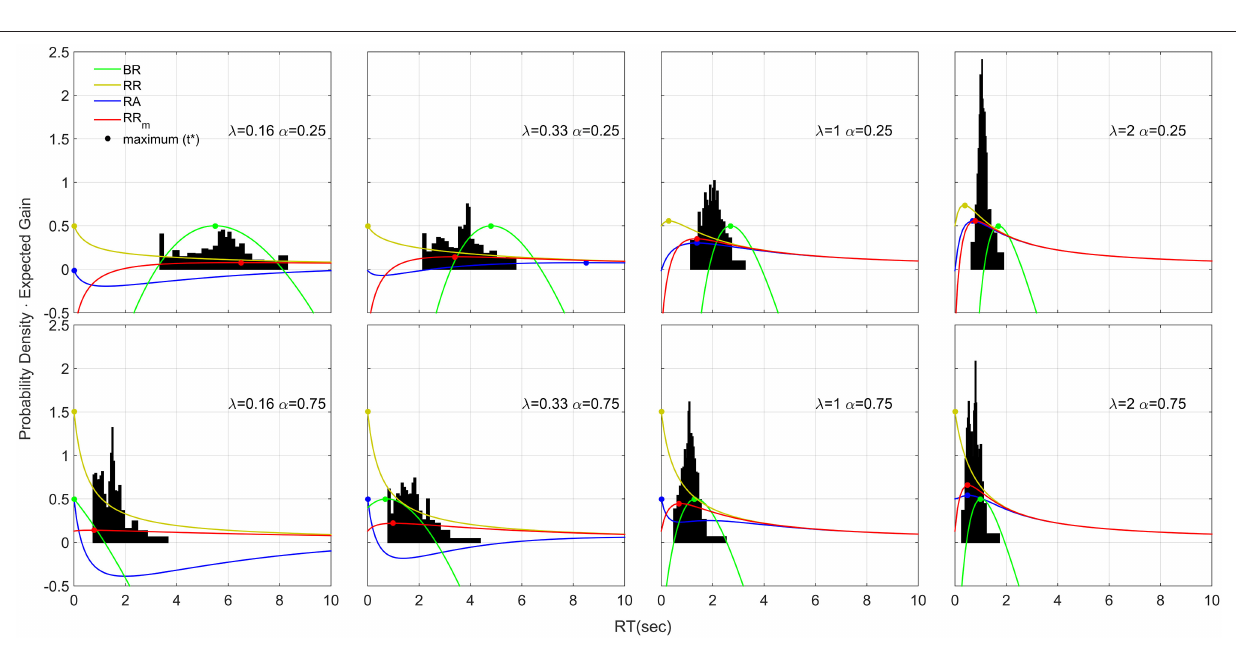
which were skewed and clearly not normal before